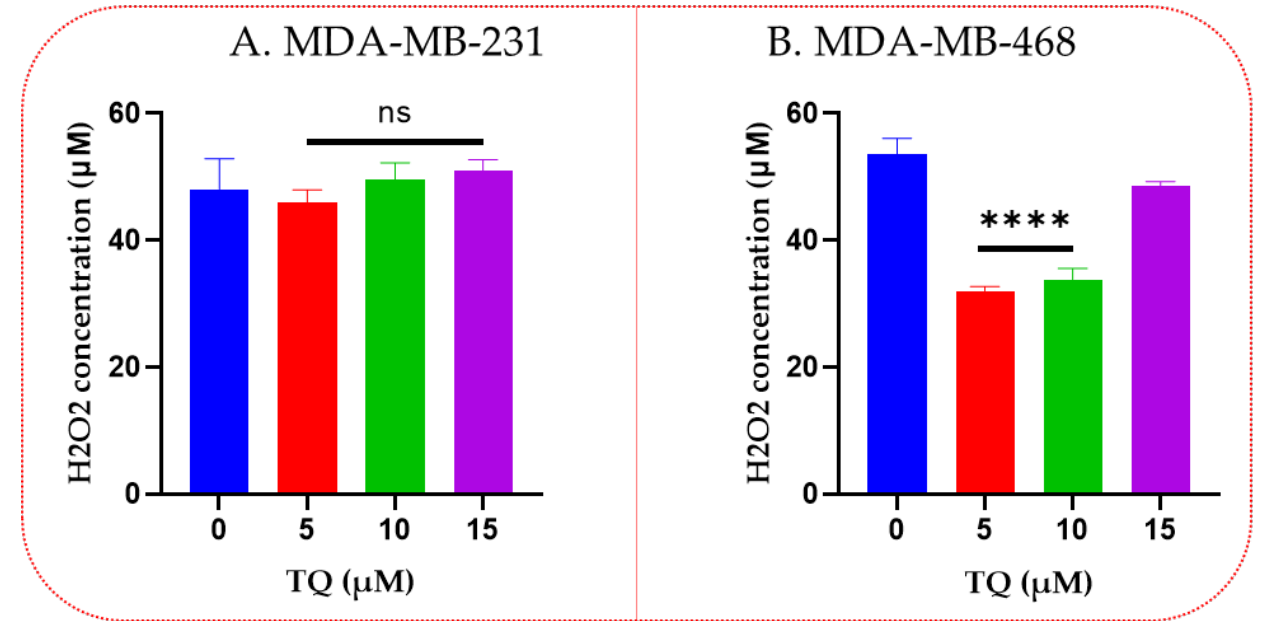
Figure 3. The concentration of H 2 O 2 following TQ treatment in TNBC cells. The levels of H 2 O 2 for MDA-MB-231( A ) and MDA-MB-468( B ) were demonstrated following treatment with TQ for 24 h at varying concentrations. The data were evaluated by one-way ANOVA. The experiment was repeated three times with n = 3, and its significance was indicated by the p -value **** < 0.0001, ns-not significance.